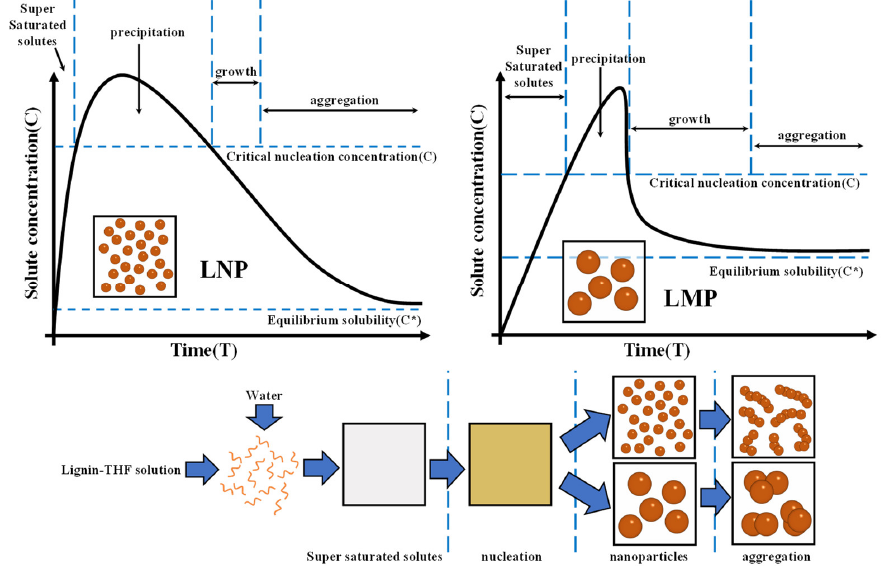
Figure 5. La Mer model [53] and schematic diagram of the lignin nanoparticle forming